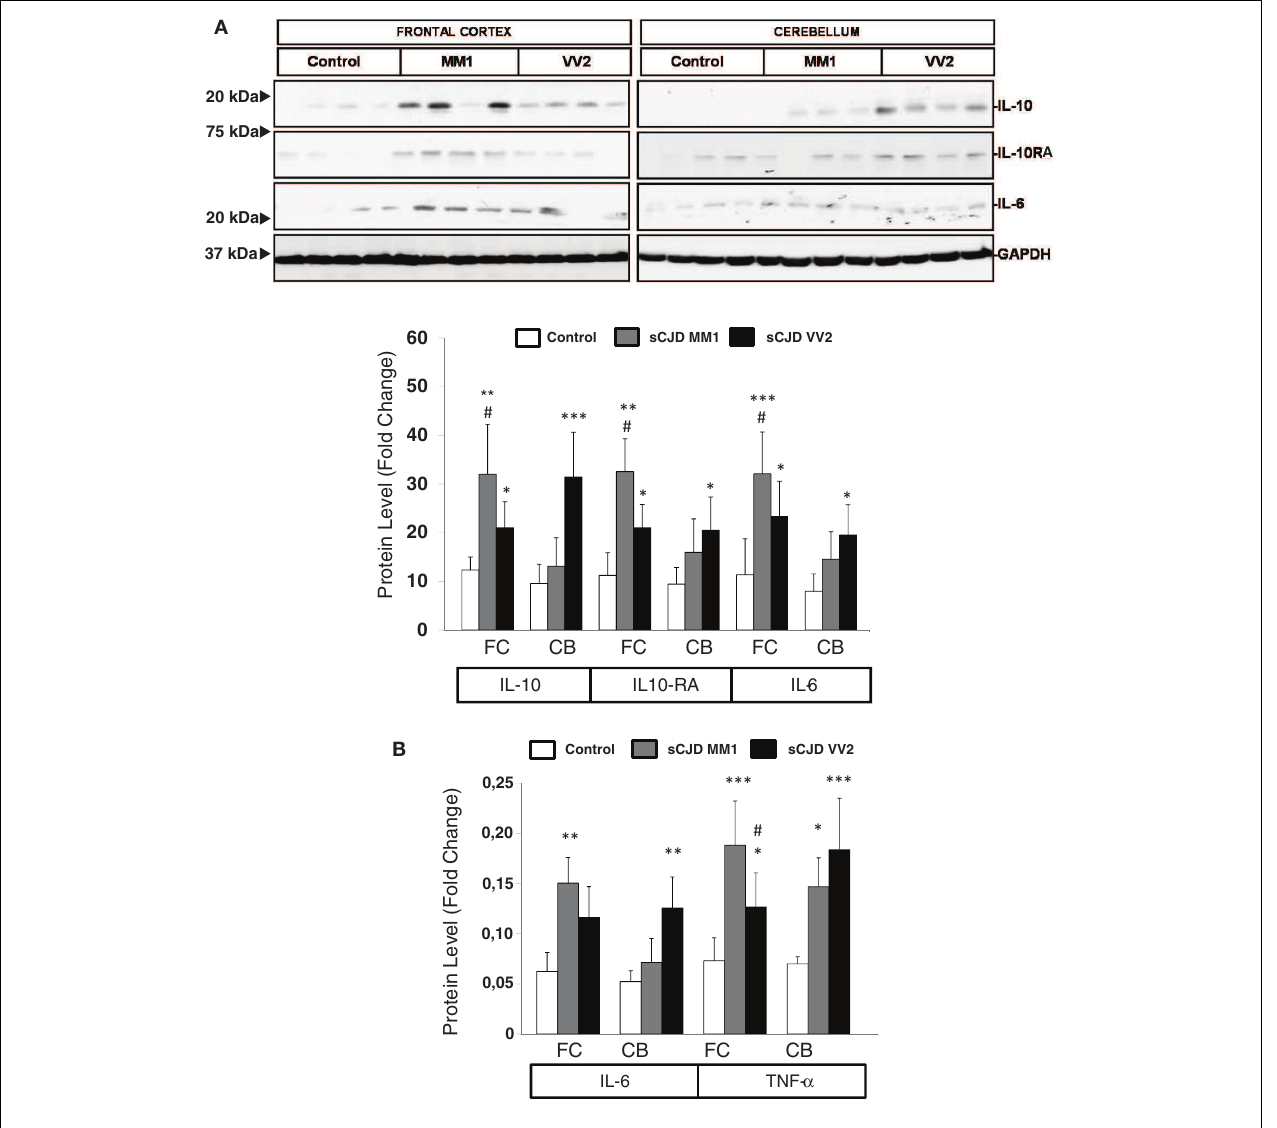
compared with sCJD; # p > 0.05, ## p > 0.005 sCJD MM1 compared with sCJDVV2. AU: arbitrary units. (B) ELISA of IL6 andTNF α in the frontal cortex and cerebellum of control, sCJD MM1, and sCJDVV2 cases. Values obtained from control ( n = 10), sCJD MM1 ( n = 10), sCJDVV2 ( n = 10) reveal significant increase in the expression of IL-6 andTNF- α in frontal cortex and cerebellum in sCJD. * p > 0.05, ** p > 0.005, *** p > 0.001: control compared with sCJD; # p > 0.05 sCJD MM1 compared with